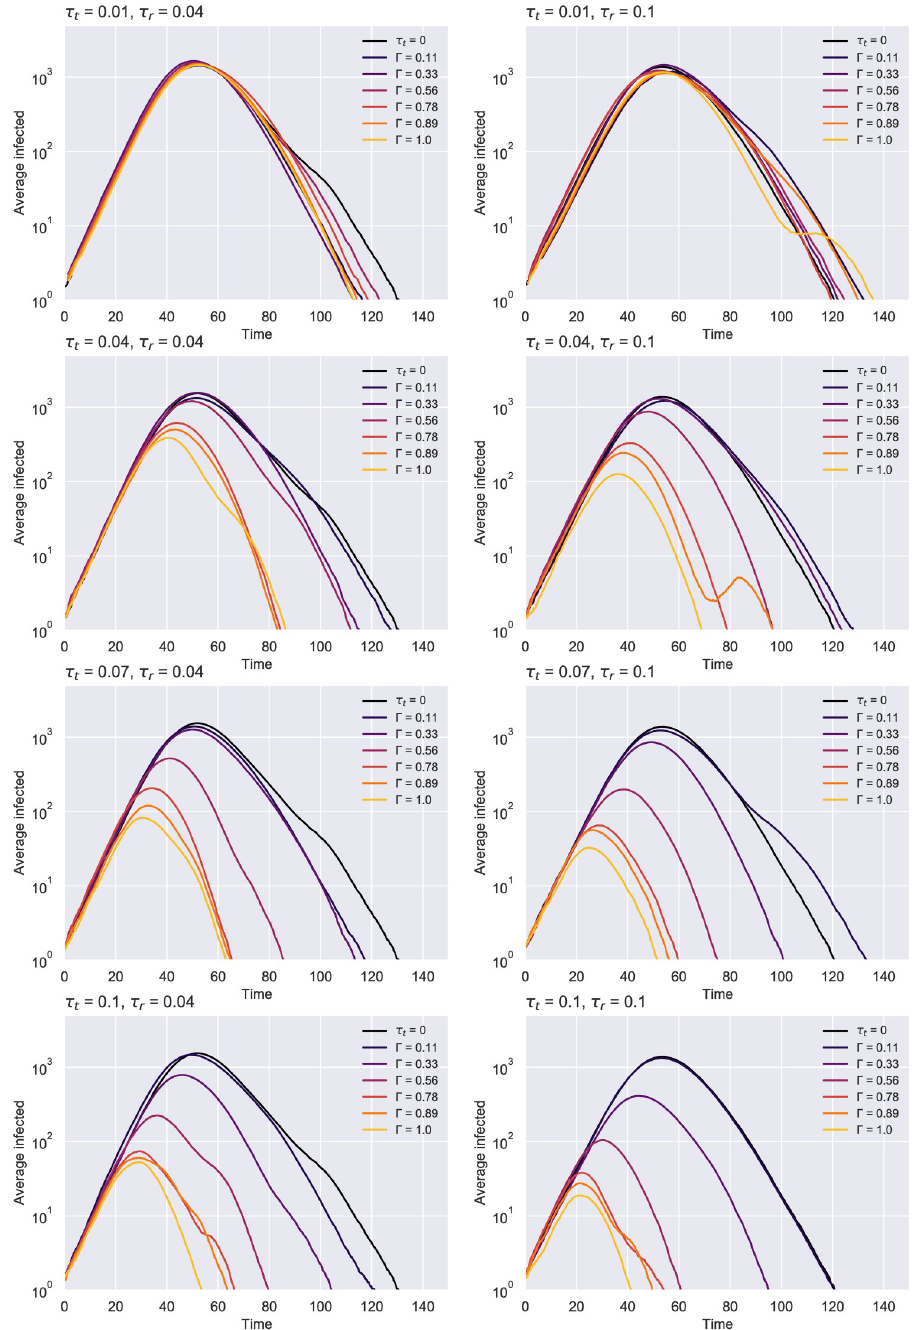
Fig 7. ER network—Epidemic evolution over time given a less efficient (left) and a more effective (right) testing regime. Results averaged over 105 simulations, obtained for N = 10000, K = 10, p a = 0.2. As the contact tracing rate increases, the accuracy of the network given by Γ becomes more important for “flattening” the curves. The case with no contact tracing ( τ t = 0) is colored in